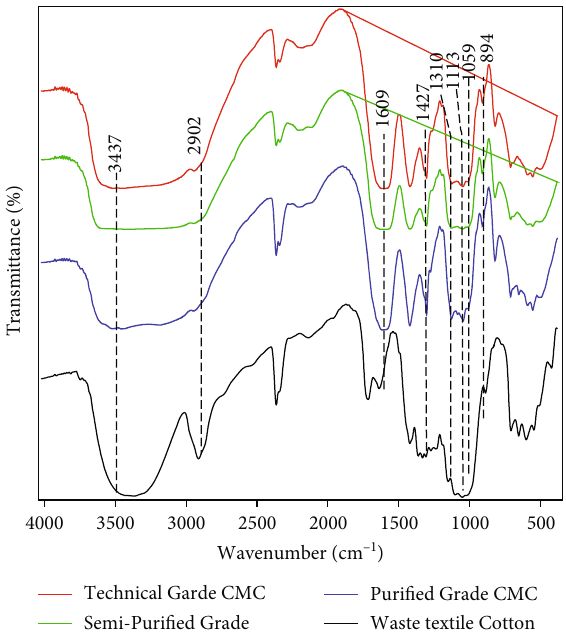
Figure 1: FTIR spectra of waste textile cotton (black), technical grade CMC (red), aemi-puri fi ed grade CMC (green), and puri fi ed grade CMC (blue).